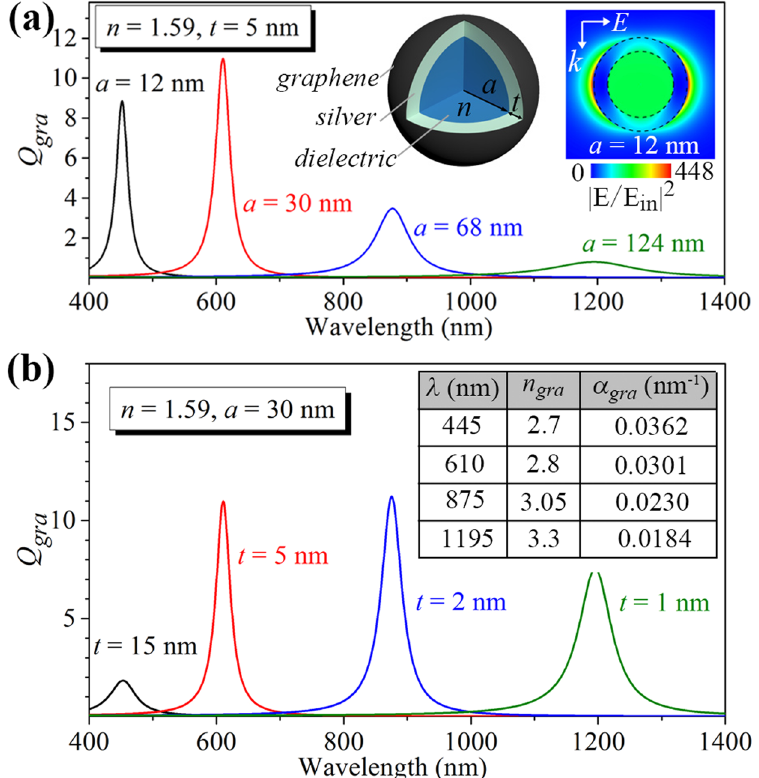
Figure 2. ( a ) Graphene absorption efficiency spectra for the graphene-wrapped DMCSRs with fixed dielectric core refractive index of n = 1.59 and silver shell thickness of t = 5 nm but different core radii. The left inset shows a schematic of a graphene-wrapped DMCSR. The right inset shows the normalized electric field intensity distribution at λ = 455 nm (corresponds to the core radius of a = 12 nm). ( b ) Graphene absorption efficiency spectra for the graphene-wrapped DMCSRs with fixed dielectric core refractive index of n = 1.59 and core radius of a = 30 nm but different silver shell thicknesses. The dielectric core radii in ( a ) and the silver shell thickness in ( b ) are chosen such that the absorption peaks appear at four given wavelengths of λ = 455 nm (black line), λ = 610 nm (red line), λ = 875 nm (blue line) and λ = 1195 nm (green line). The inset table in ( b ) shows the refractive index and the absorption coefficient of monolayer graphene at the wavelengths of λ = 455 nm, 610 nm, 875 nm and 1195